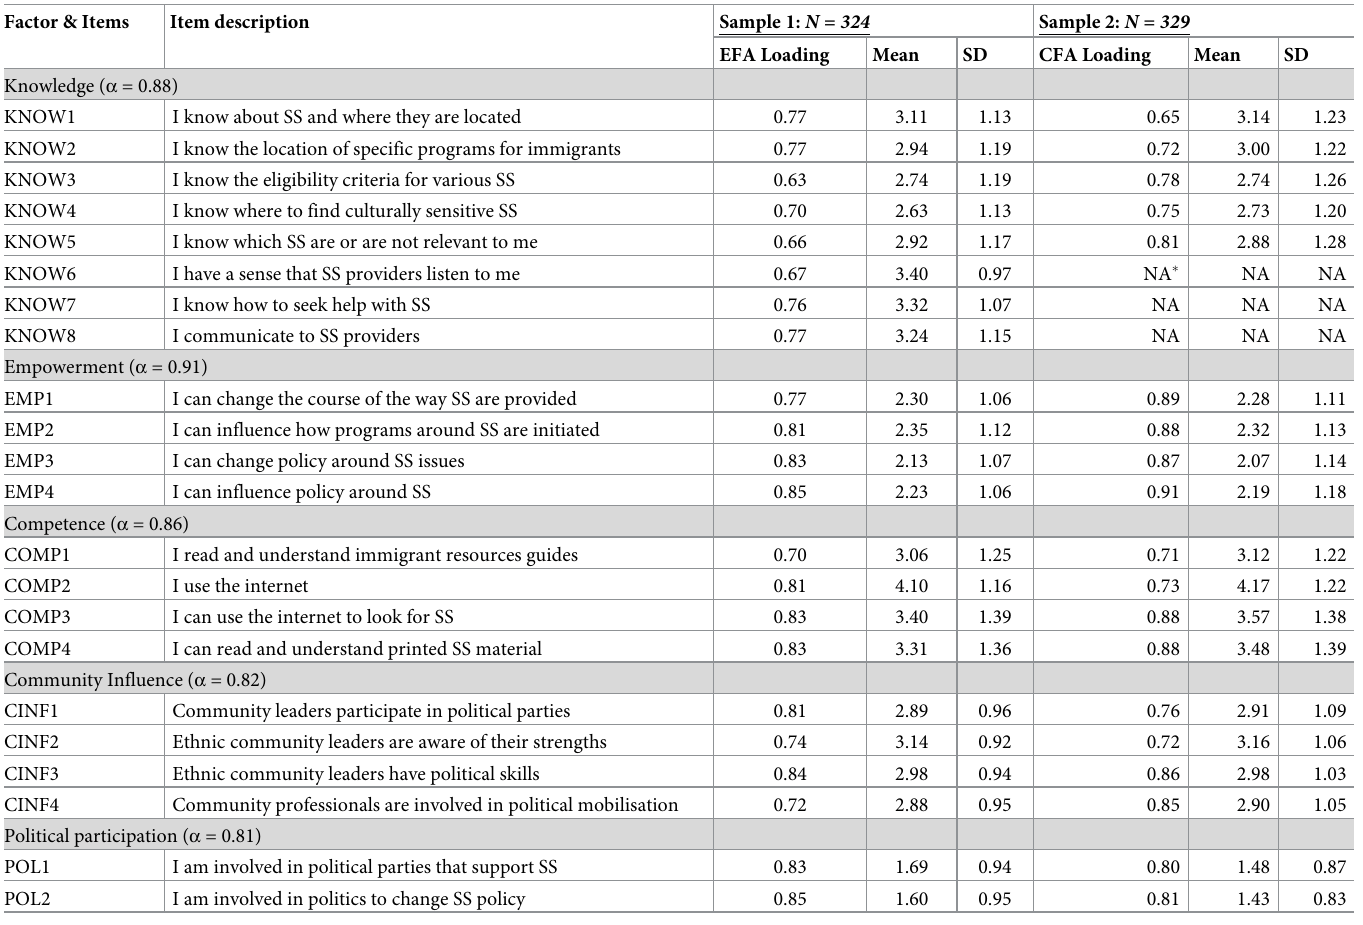
Table 3. Factor loadings, item means, standard deviation (SD), and Cronbach alpha coefficients for the two